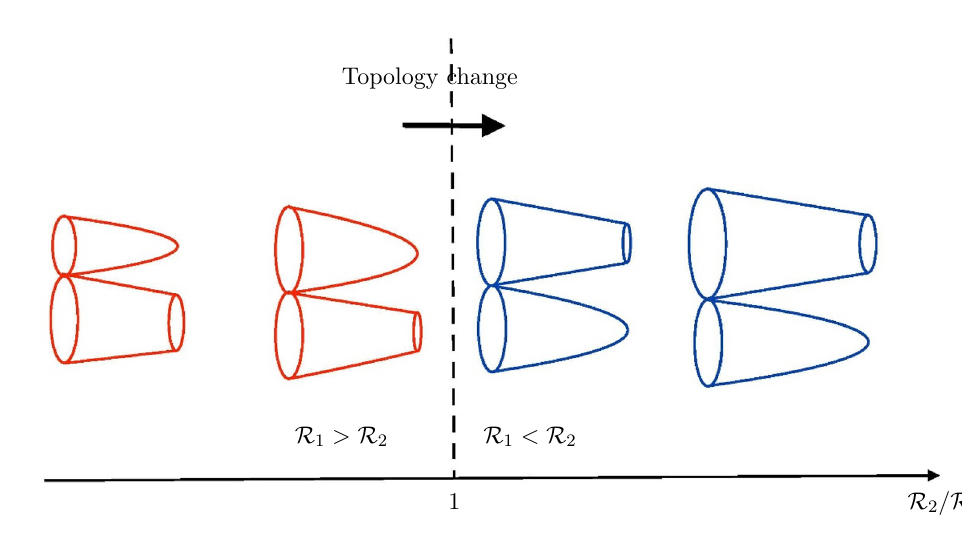
Figure 3 . Conifold transition. The horizontal axis represents the ratio of the UV curvatures of the two spheres. In this (cid:12)gure the UV radius of sphere 2 is kept (cid:12)xed, while that of sphere 1 is increased going from left to